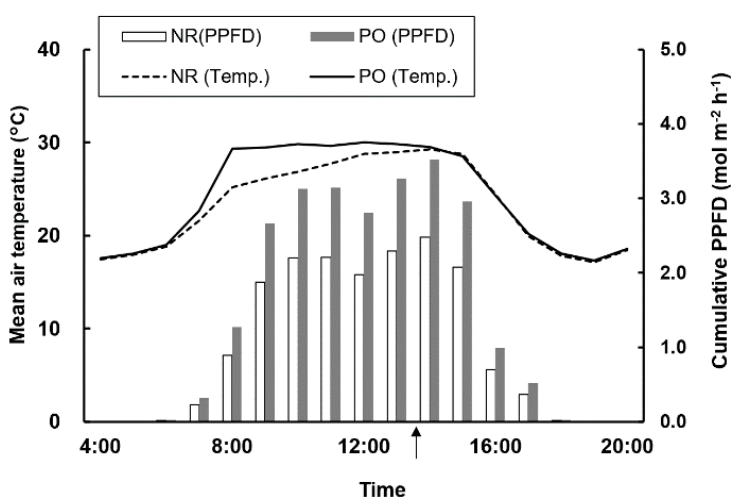
Figure 6. Daily change in microclimate in the high tunnels covered with NR or PO at 52 DAT. The arrow below the X -axis indicates the time of fruit temperature measurement.